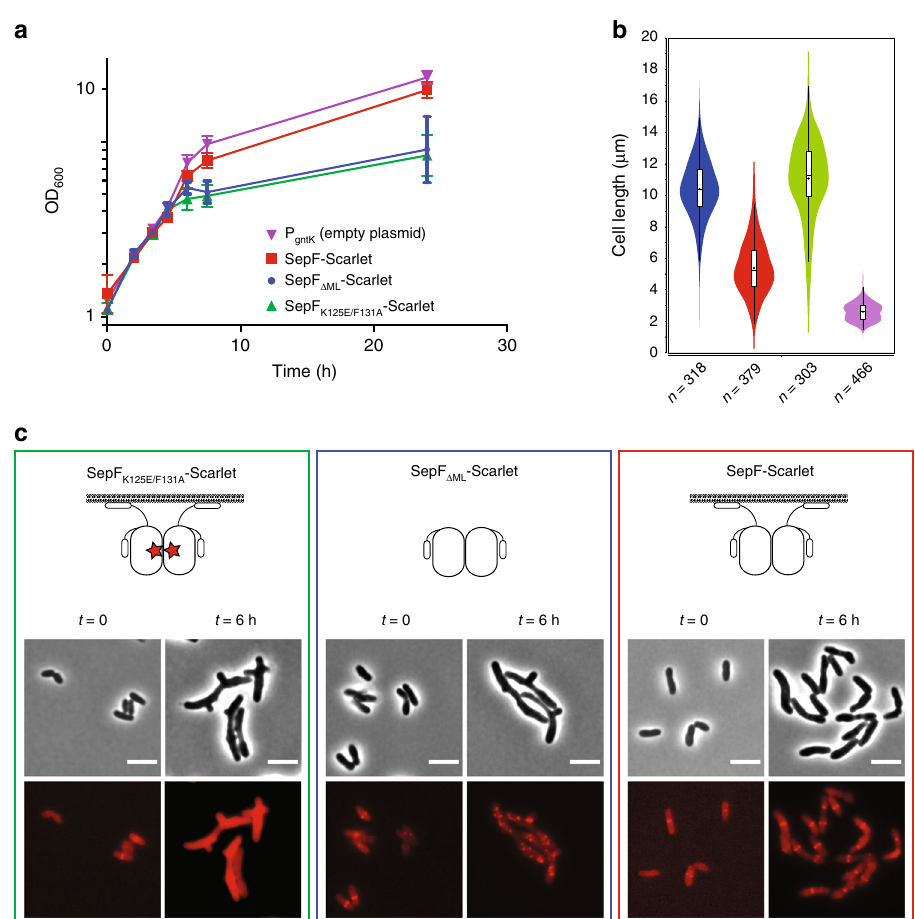
Fig. 3 Complementation and localization of SepF mutants in the P ino -sepF strain. a Growth curves of SepF-Scarlet (red), SepF Δ ML -Scarlet (blue), SepF K125E/F131A -Scarlet (green) expressed in the P ino -sepF-P gntK background in 1% myo -inositol plus 1% gluconate and P ino -sepF-P gntK strain in 0% myo - inositol plus 1% gluconate (purple). Error bars represent the mean ± SD. b Violin plot showing the distribution of cell length at time point 6 h after myo - inositol and gluconate addition for the strains corresponding to the growth curve (same color code). The number of cells used in the analyses ( n ) is indicated below each violin representation. The box indicates the 25th to the 75th percentile and the whiskers indicate the 95% con fi dence interval. The mean and the median are indicated with a dot and a line in the box, respectively. c Representative images in phase contrast (upper row) and Scarlet fl uorescent signal (lower row) of the complemented strains of a . t = 0 corresponds to the strains before depletion by myo -inositol and induction of exogenous P gntK controlled constructs by gluconate. Western blots of whole-cell extracts from the above strains during depletion, as well as triplicate analyses for the distribution of cell length at time points 6 h are shown in Supplementary Fig. 11. The data shown are representative of experiments made independently in triplicate. Scale bars = 5 μ m. Source data are provided as a Source Data fi